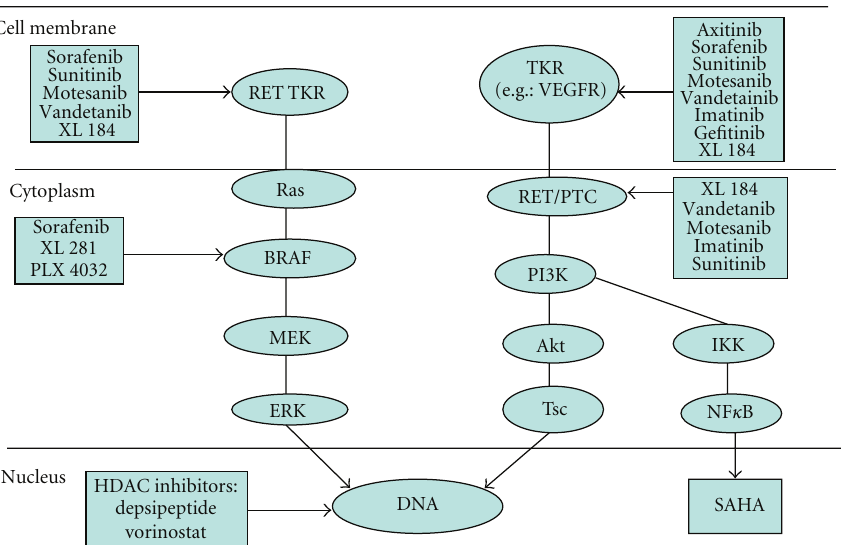
Figure 1: Molecular pathways of thyroid cancer and their corresponding therapeutic